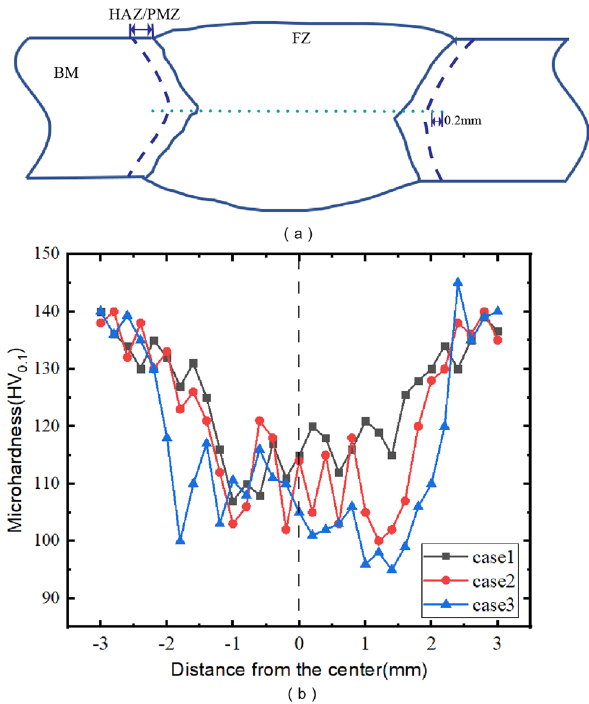
Figure 10: Microhardness of the weld. ( a ) Location of hardness test; ( b ) the curve of